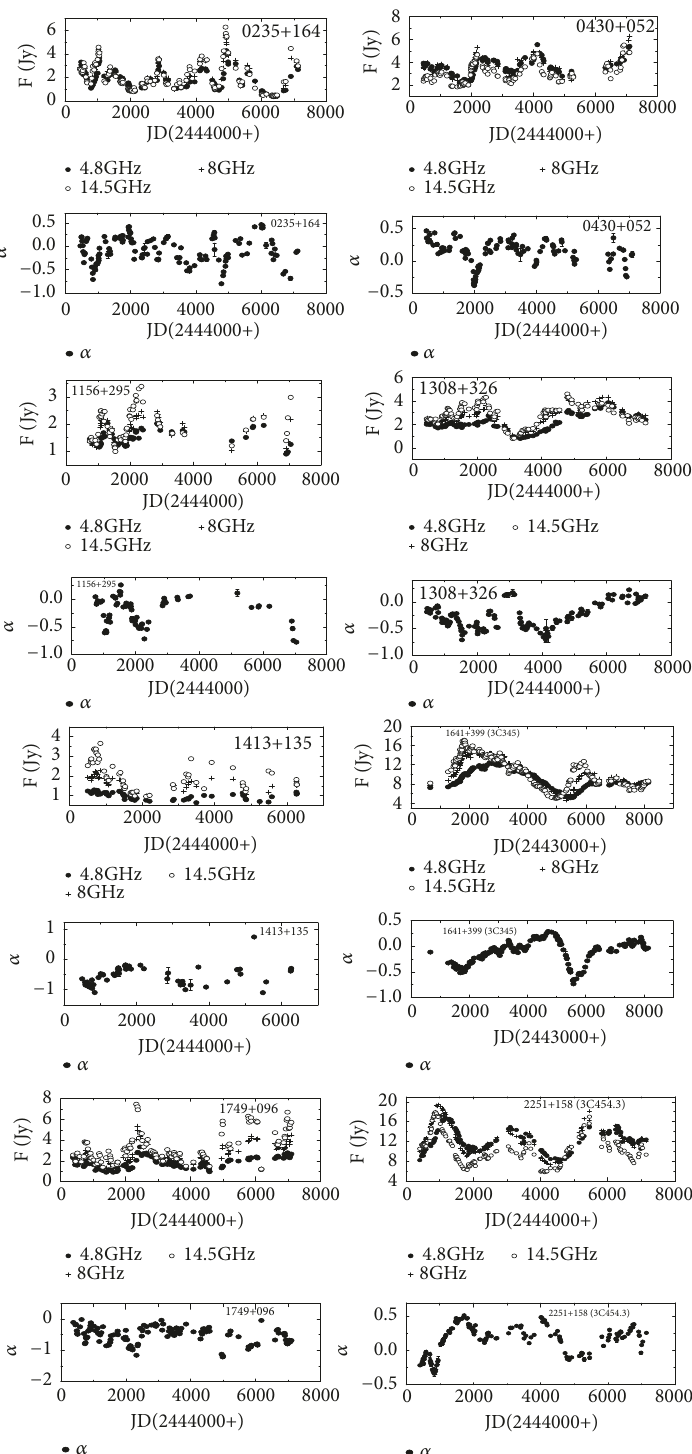
Figure 1: Theaveragedflux densities and spectralvariances of the8 sources,i.e.,0235+164,0430+052,1156+295, 1308+326, 1413+135,1641+399 (3C 345), 1749+096, and 2251+158 (3C 454.3) as a function of time measured in JD. The averaged flux densities are shown in the upper panels and the spectral variances are shown in the lower panels, in which the filled circles stand for 4.8 GHz, the crosses stand for 8 GHz, and the open circles stand for 14.5